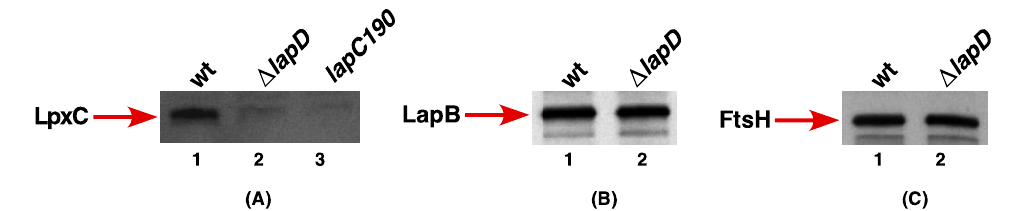
Figure 5. An absence of LapD causes a reduction in the amounts of LpxC. An immunoblot of whole cell lysates obtained from isogenic strains with indicated genotypes using LpxC-specific antibodies ( A ). In parallel, samples from the wild type and Δ lapD were immunoblotted with LapB-specific antibodies ( B ) and with FtsH-specific antibodies ( C ). An equivalent amount of total proteins was resolved by SDS-PAGE prior to immunoblotting.